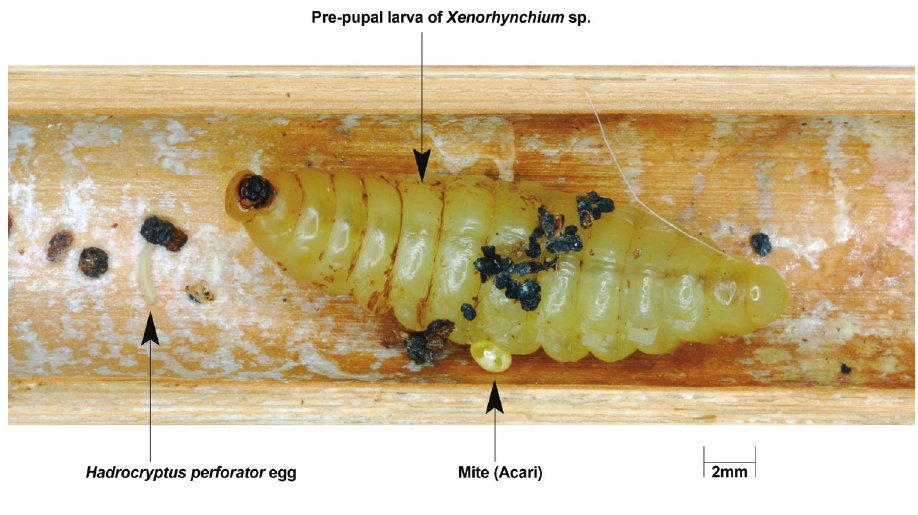
Figure 2. Trap NTC-028.A4 at opening.